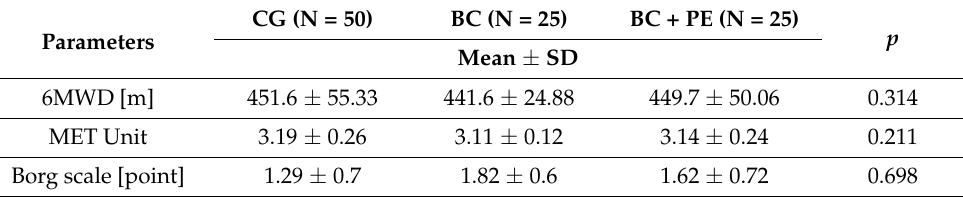
Table 2. Physical capacity test results for the study participants. Parameters